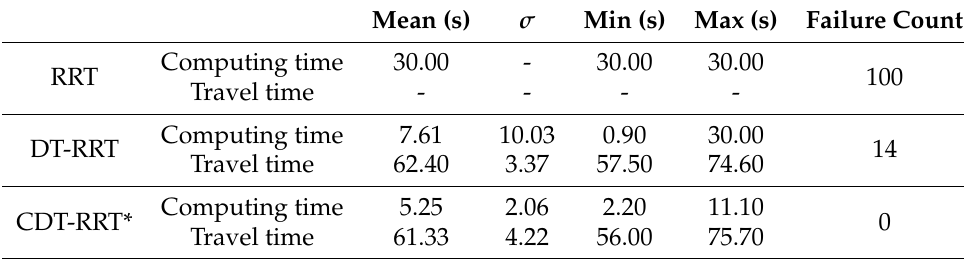
Figure 14. Histogram of the computing time for the results from simulation 6. Table 7. Summary of Planning Results from simulation 6.